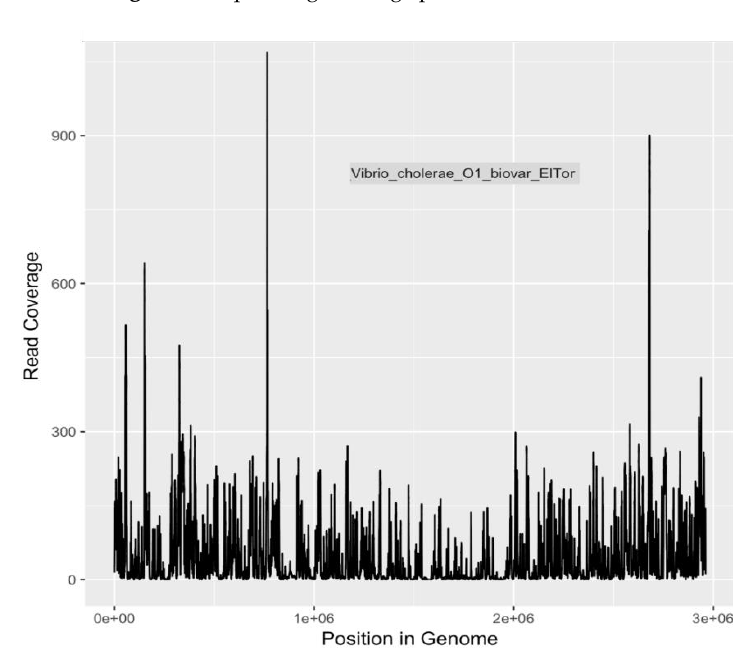
Figure 5. Sequencing coverage plot for V. cholerae O1 El Tor.